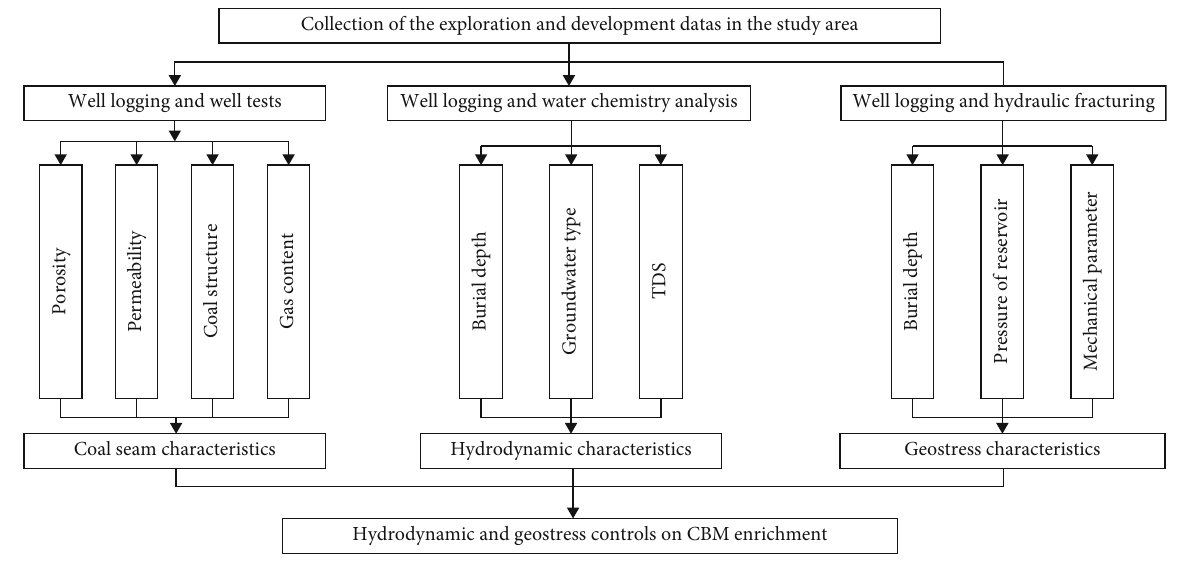
Figure 1: The research fl ow